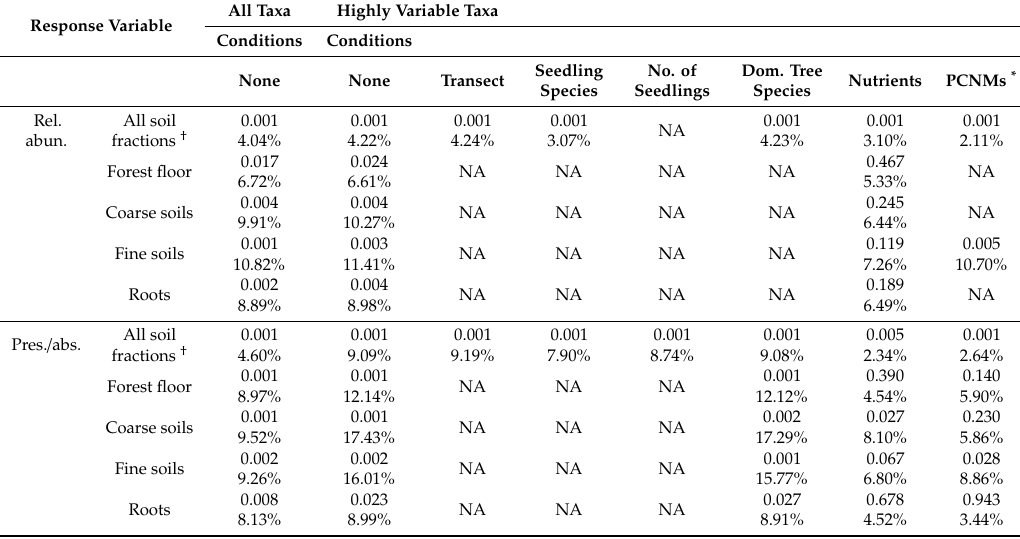
Figure 4. The e ff ects of distance from the forest edge as depicted by partially constrained ordinations of the relative abundances and presence or absence of fungal taxa with variance greater than 0.000,01 across samples ( A and B , respectively), the relative abundance of fungal trophic functions ( C ) and the number of fungal taxa belonging to fungal trophic functions ( D ) in root, forest floor, fine soil, and coarse soil fractions assessed jointly, while removing effects of soil fraction. Both species and sites scores are symmetrically scaled by the square root of eigenvalues for plot clarity. Polygons represent k-means clustering based on axes 1 and 2. High relative abundance of Tomentella coerulea and Hebeloma circinans are responsible for the divergent forest floor sample at 10 m in panel A. AM, arbuscular mycorrhiza; AP, animal parasite; APG, animal pathogen; AS, animal endosymbiont; EM, ectomycorrhiza; EP, endophyte; ER, ericoid fungus; L, lichenized fungus; LC, lichenicolous fungus; MP, mycoparasite; PP, plant pathogen; SBR, saprotrophic brown rot; SFY, saprotrophic facultative yeast; ST, saprotroph; SWR, saprotrophic white rot; SY, saprotrophic yeast; UK, unknown;.